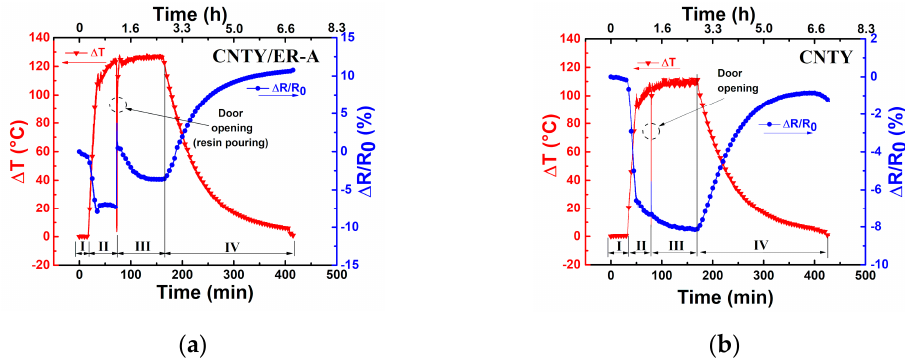
Figure 3. Change in electrical resistance and temperature during the curing resin process of CNTY/ER-A. ( a ) CNTY/ER-A, ( b ) freestanding CNTY under the same temperature program.